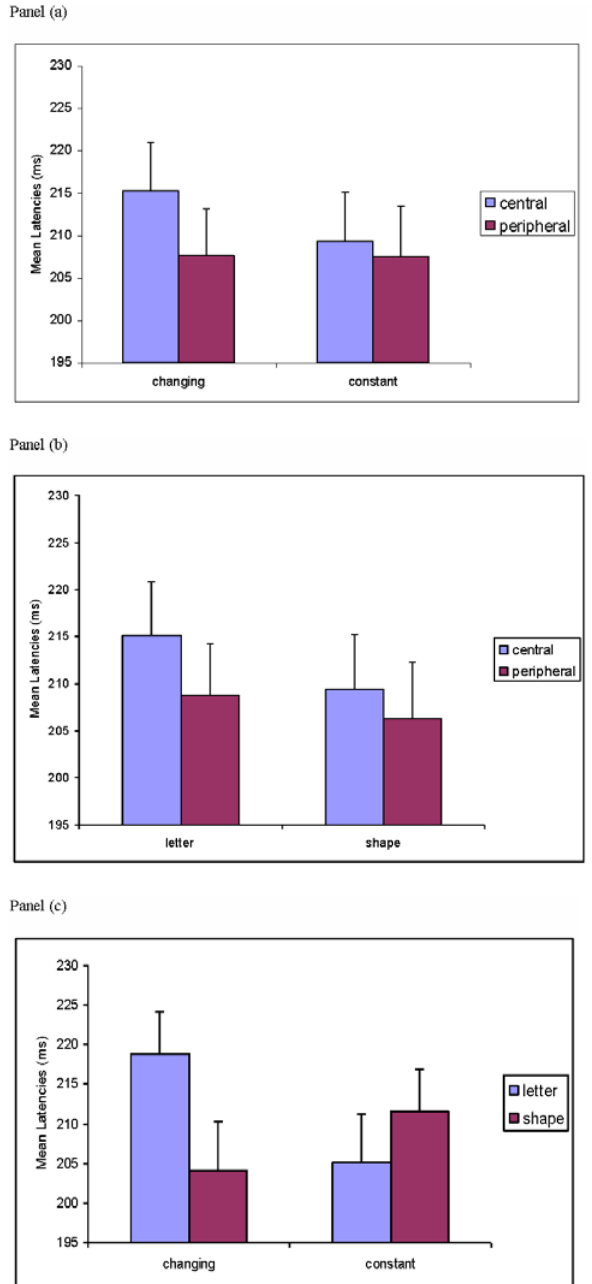
Figure 2:Panel (a). The mean saccade latencies for changing and repeated distractors for each of the distractor eccentricities. Panel (b). The mean saccade latencies for letter string and shape string distractors for each of the distractor eccentricities. Panel (c). The mean saccade latencies for changing and repeated distractors for uniform letter strings, and uniform shape strings. Error bars denote 1 standard error from the